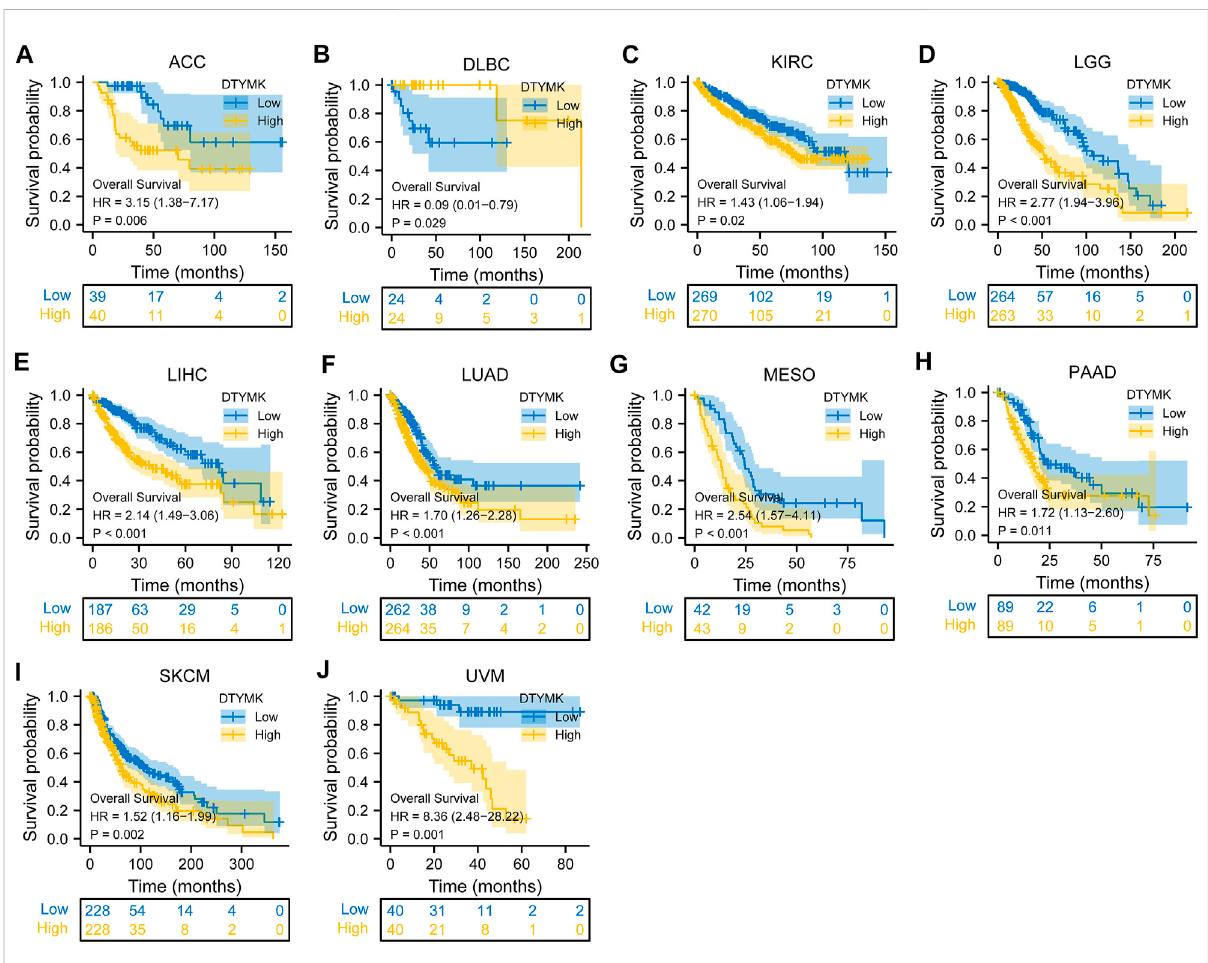
Figure 1B. Taken together, these results suggested that DTYMK was abnormally expressed in pan-cancer